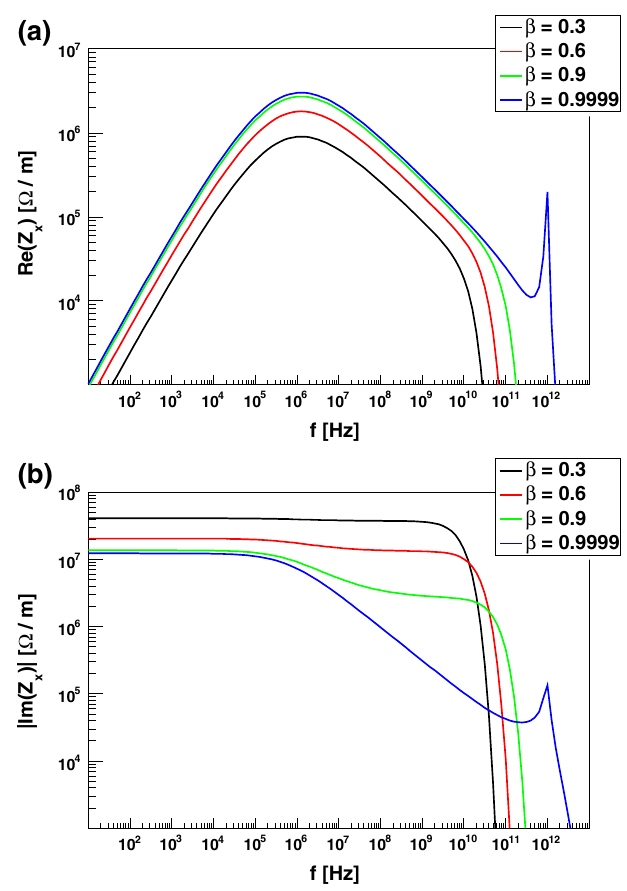
FIG. 17. (Color) (a) Real and (b) imaginary part of the trans- verse wall impedance for different values of the relativistic factor (cid:9) .